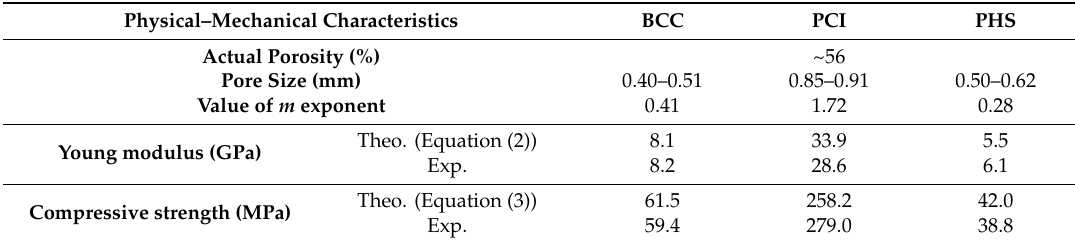
Table 5. Values of m exponent applied to predict the Young modulus and compressive strength of each lattice structures designed and SLM-manufactured from